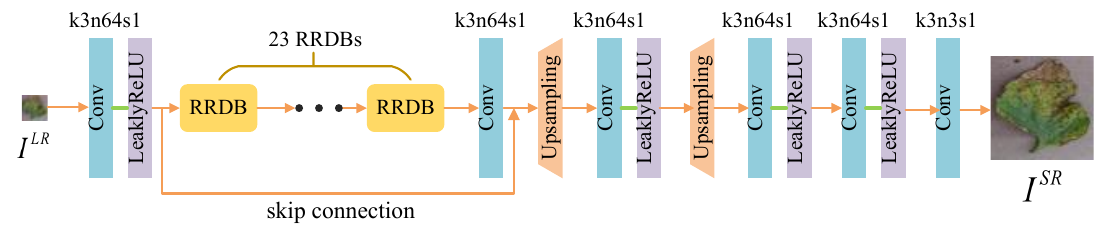
Figure 2. Architecture of generator network G . In each convolutional layer, k , n , and s represent kernel size, number of feature maps, and